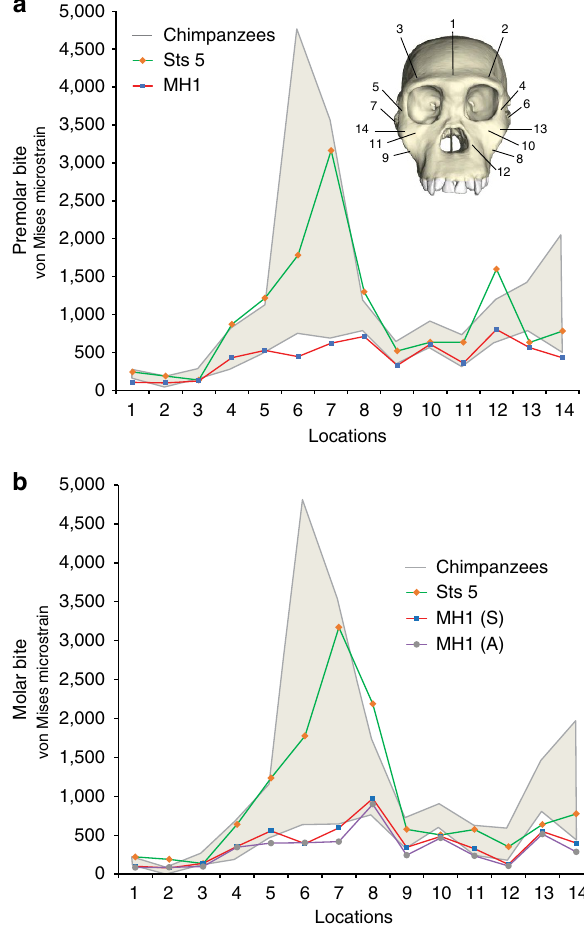
Figure 1 | Line plot of von Mises strain generated during simulated biting in finite element models. Strain data correspond to ( a ) left premolar (P 3 ) and ( b ) left molar biting (M 2 ), recorded from 14 homologous locations across the craniofacial skeleton of finite element models of Sts 5 ( A. africanus ) and MH1 ( A. sediba ). The grey region brackets the range of variation exhibited by six chimpanzee crania intentionally selected to be morphologically different. For the molar biting analysis, it was necessary to rerun the model of MH1 with the balancing (non-biting) side muscle forces reduced by nearly 30% to remove a distractive (tensile) reaction force at the working (biting) side jaw joint. Therefore, data for both the symmetrical (S) and asymmetrical (A) loadings are